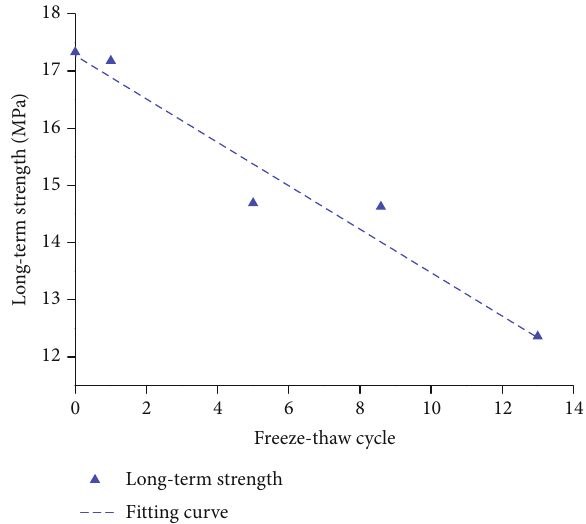
Figure 20: Curves of the long-term strength versus the number of freeze-thaw cycles under 2MPa of con fi ning pressure.